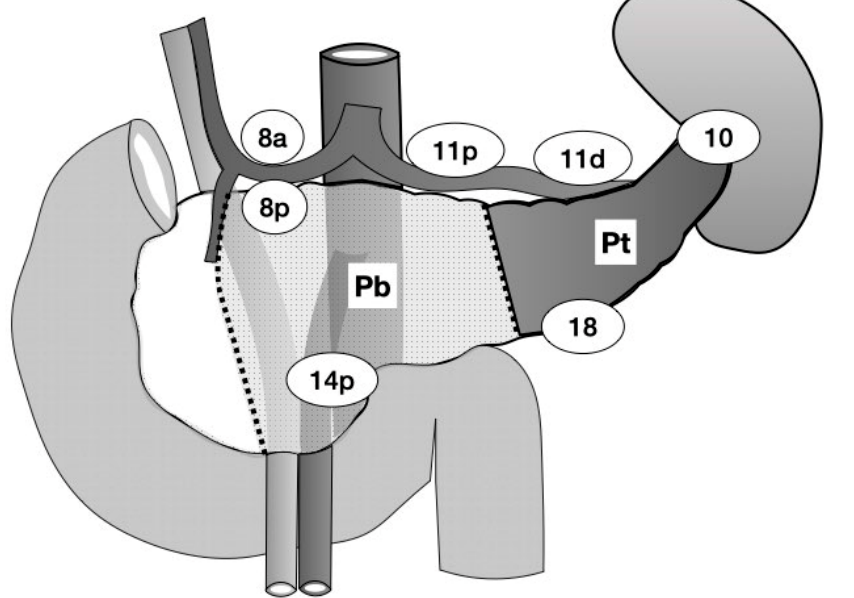
Figure 1. The dotted line indicates the border of each location. The dark area indicates the pancreatic tail (Pt) tumor site. The light-dotted area indicates the site of the pancreatic body (Pb) tumor. Pbt tumors spread to both the Pb and Pt sites. The number in the circle indicates the name of lymph node station according to the Japanese Classification of Gastric Carcinomas.